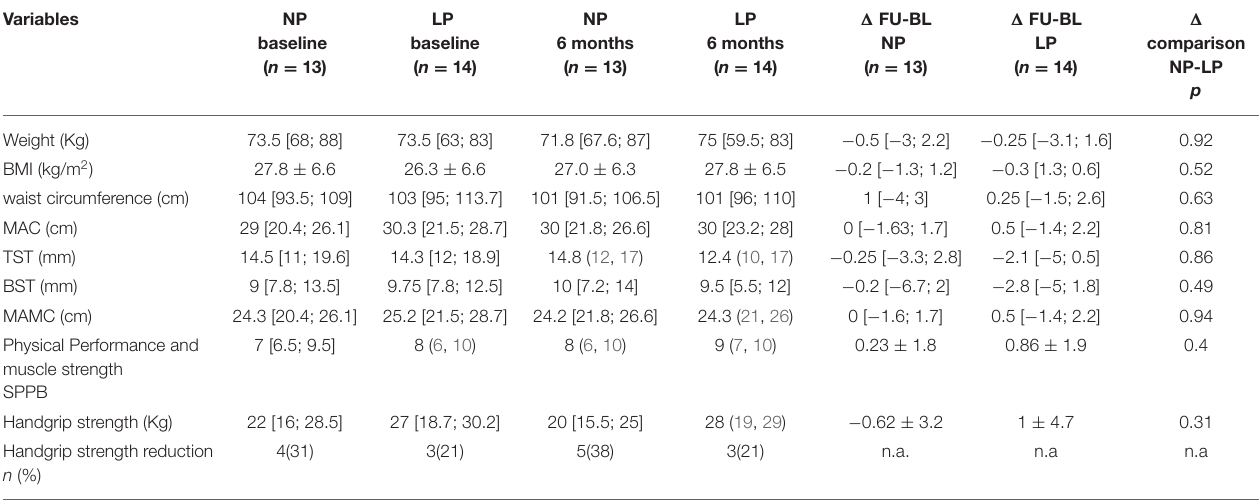
TABLE 3 | Body composition, physical performance, and muscle strength (baseline vs. 6